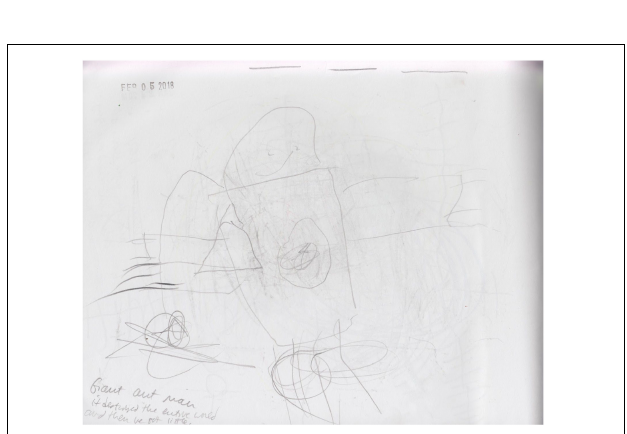
FIGURE 4 | Pictures 10 detailing a story from Orlando, a 6-year-old